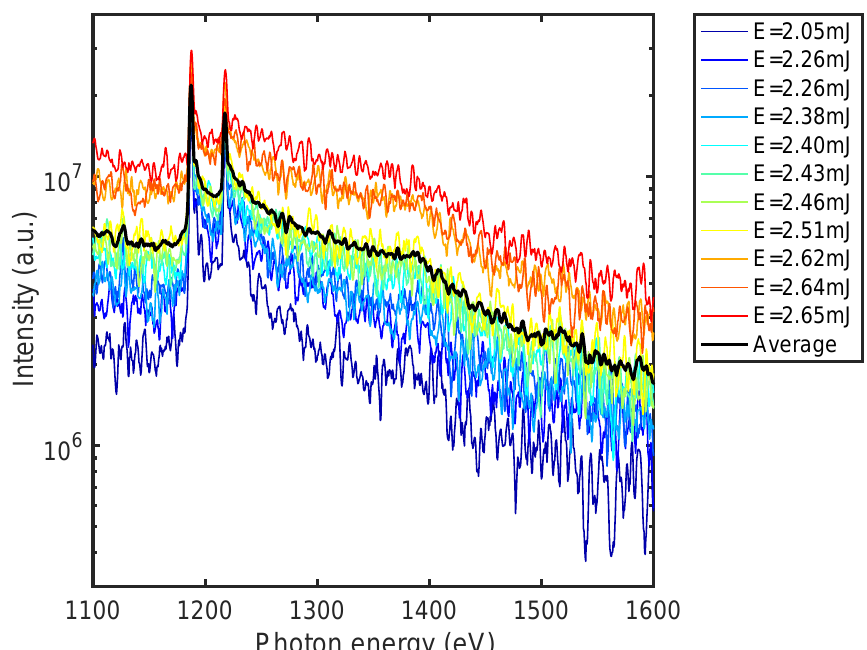
Figure 6. Spectra obtained for the different shots with a XFEL photon energy of 1400 eV as a function of the beam energy. The small variations in the beam energy affect the spectral intensity, and effectively, the temperature of the plasma.